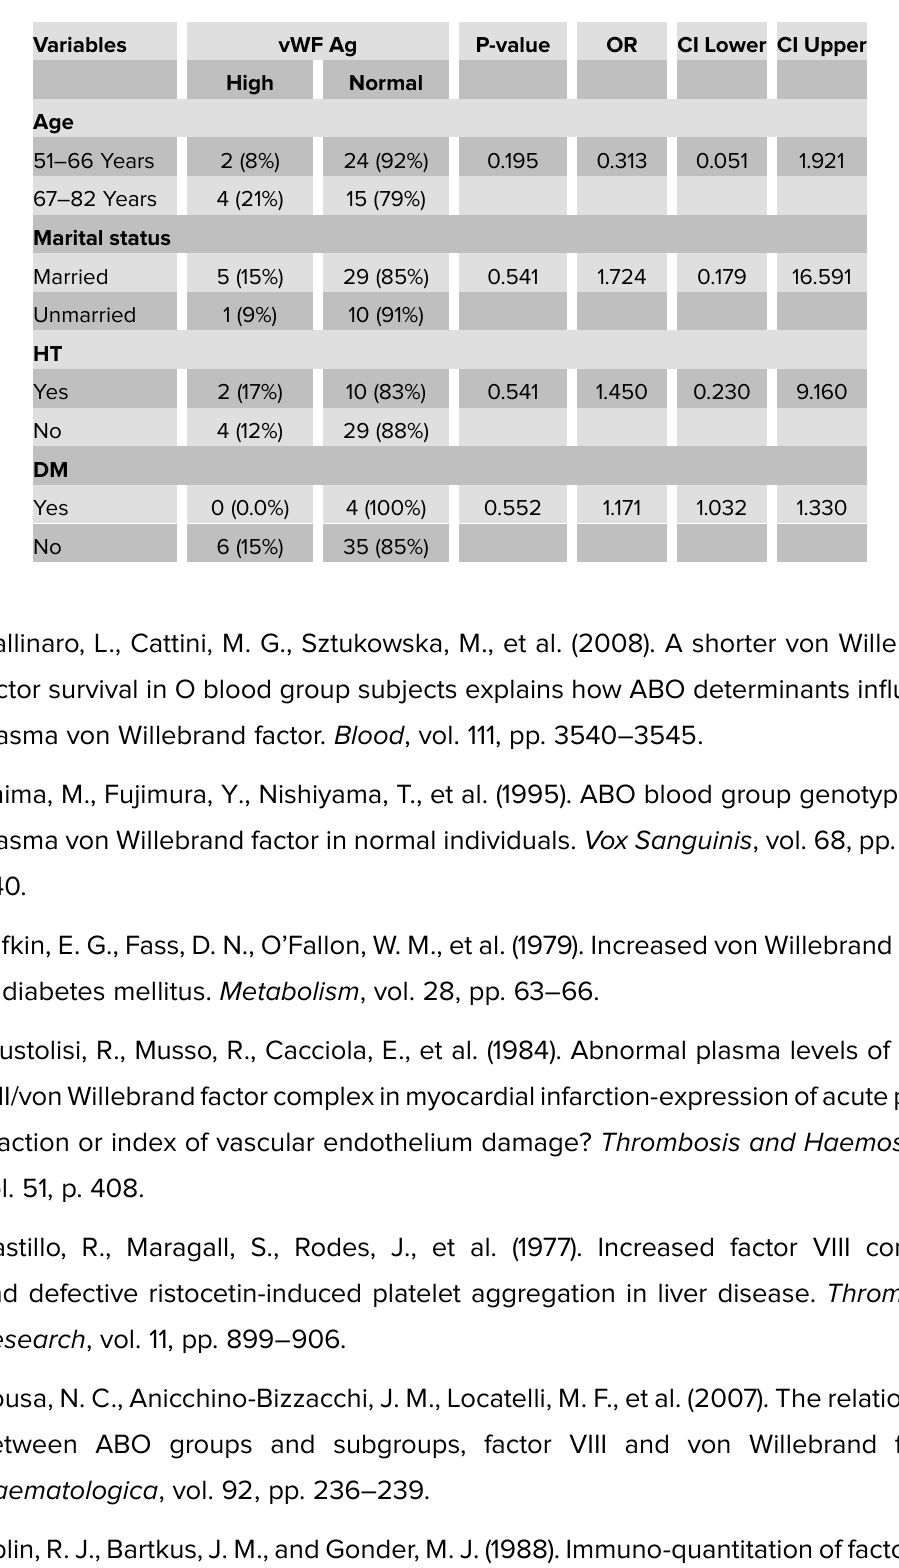
Table 2: Correlation between variables and study